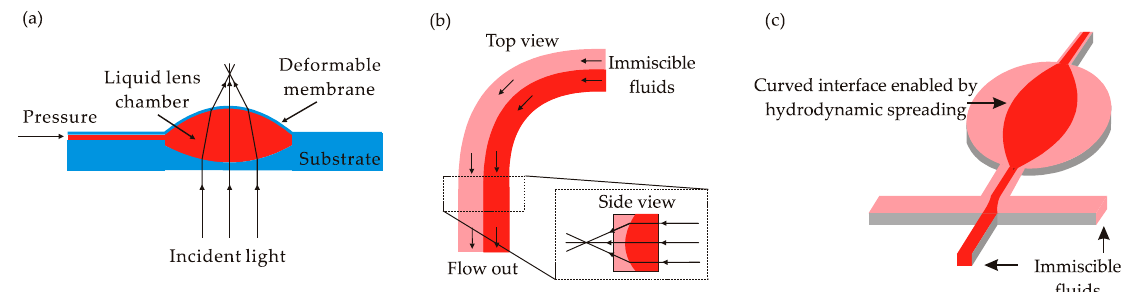
Figure 4. Illustration of optofluidics lenses: ( a ) out-of-plane lens tuned by applying pressure on a deformable membrane; ( b ) in-plane lens enabled by Dean flow; and ( c ) in-plane lens configured by liquid core liquid cladding structure.